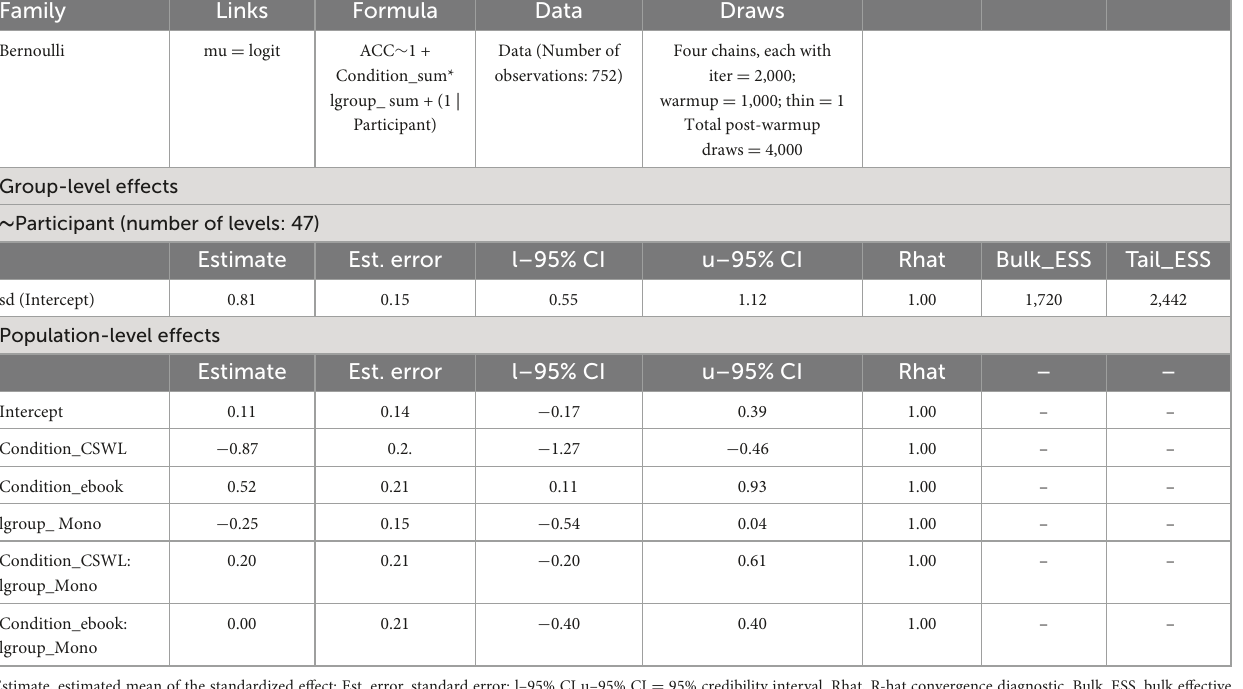
TABLE 1 “Condition*lgroup summed Model” as per standard notation used in R. Family